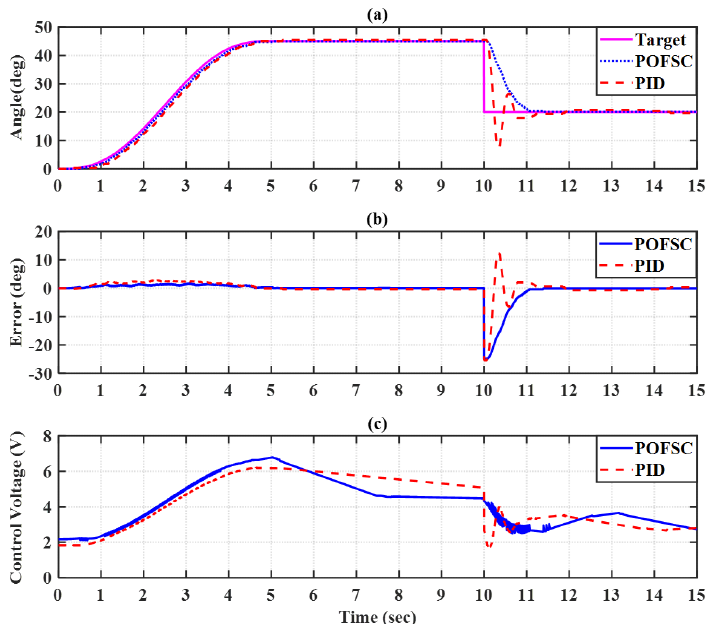
Figure 19. Safety test and comparison of the POFSC and PID in the shoulder joint of WURAES. ( a ) System response, ( b ) tracking error, and ( c ) control voltage.